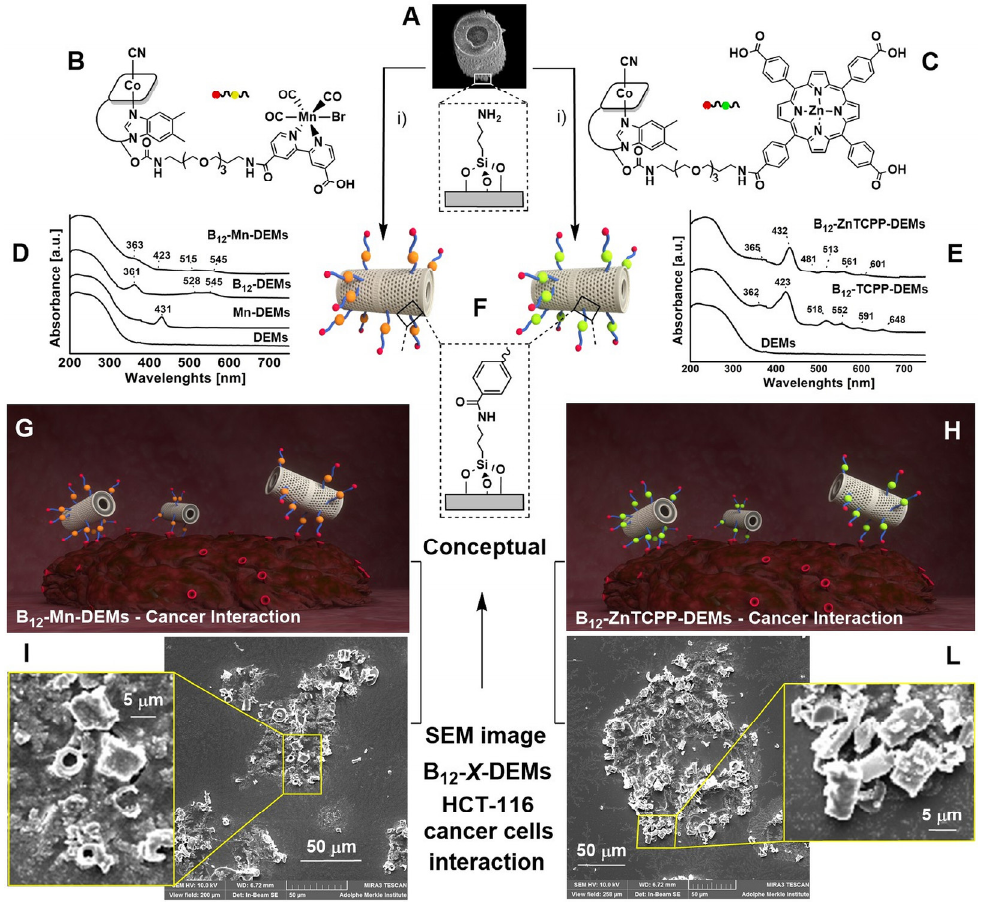
Figure 2 Figure 2. ( A ) SEM image of one raw diatom piece. ( B , C ) Structures of B 12 -Mn and B 12 -ZnTCPP, respectively. ( D , E ) Solid-state UV-Vis spectra of di ff erent functionalized DEMs. ( F ) Conceptual drawing of functionalized B 12 - X -DEMs ( X = Mn or ZnTCPP) and detail of molecular bonding at the surface of microalgae. ( G , H ) Conceptual images of B 12 -Mn-DEMs and B 12 -ZnTCPP-DEMs interacting with a tumor mass. ( I , L ) SEM images of B 12 derivatized DEMs attached to HCT-116 colorectal cancer cells and representative